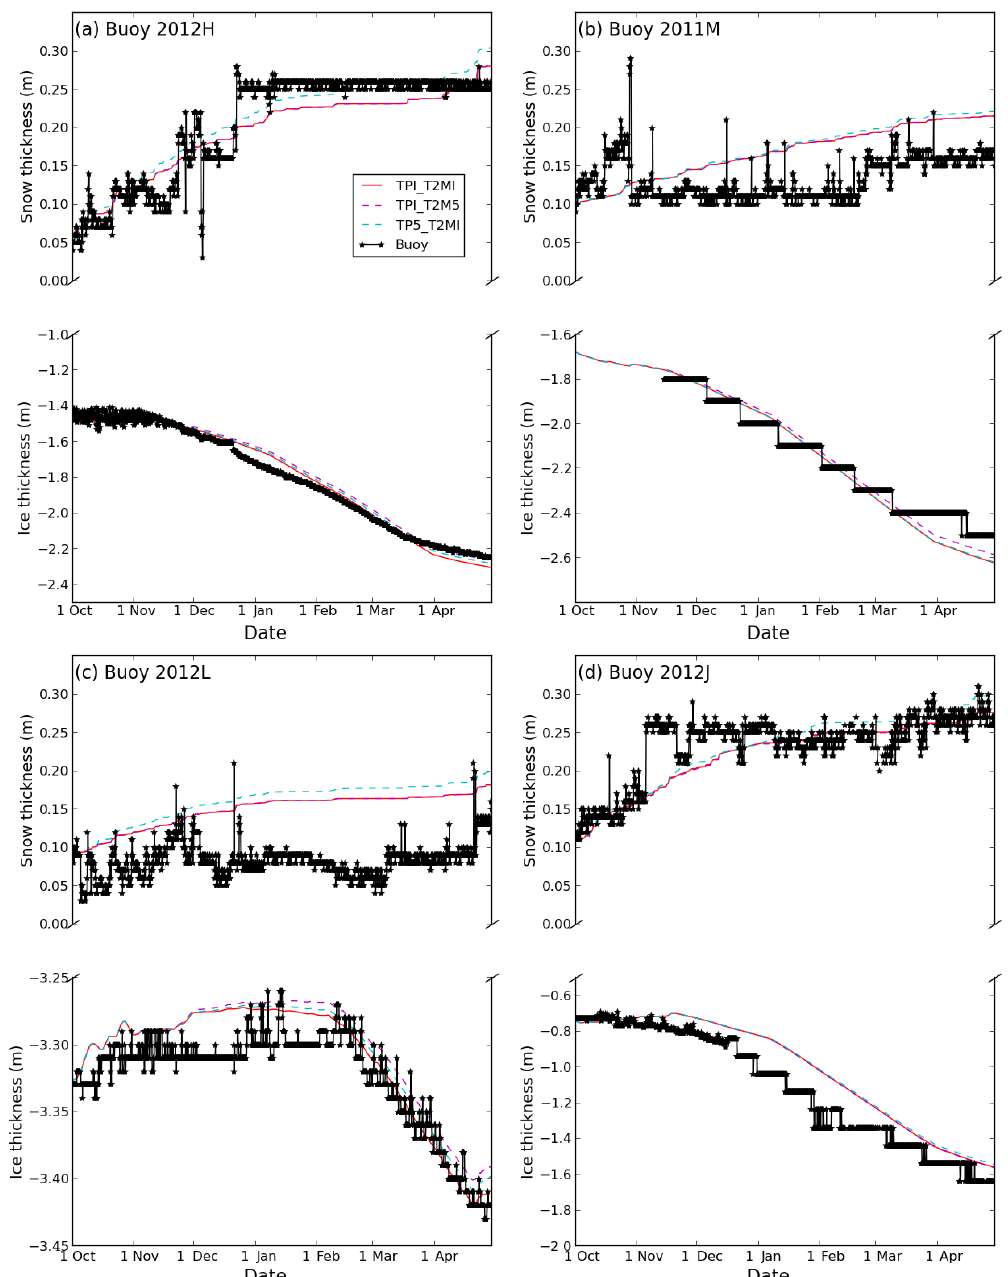
Figure 10. Same as Fig. 9, but for model runs TPI_T2M5 and